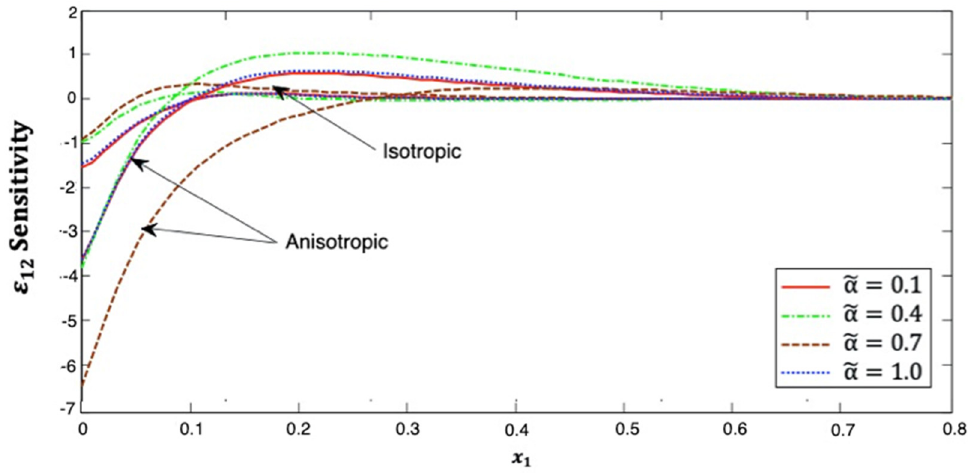
Figure 9. Distribution of the ε 12 sensitivity along x 1 –axis in isotropic and anisotropic FRP composites for various fractional-order values.